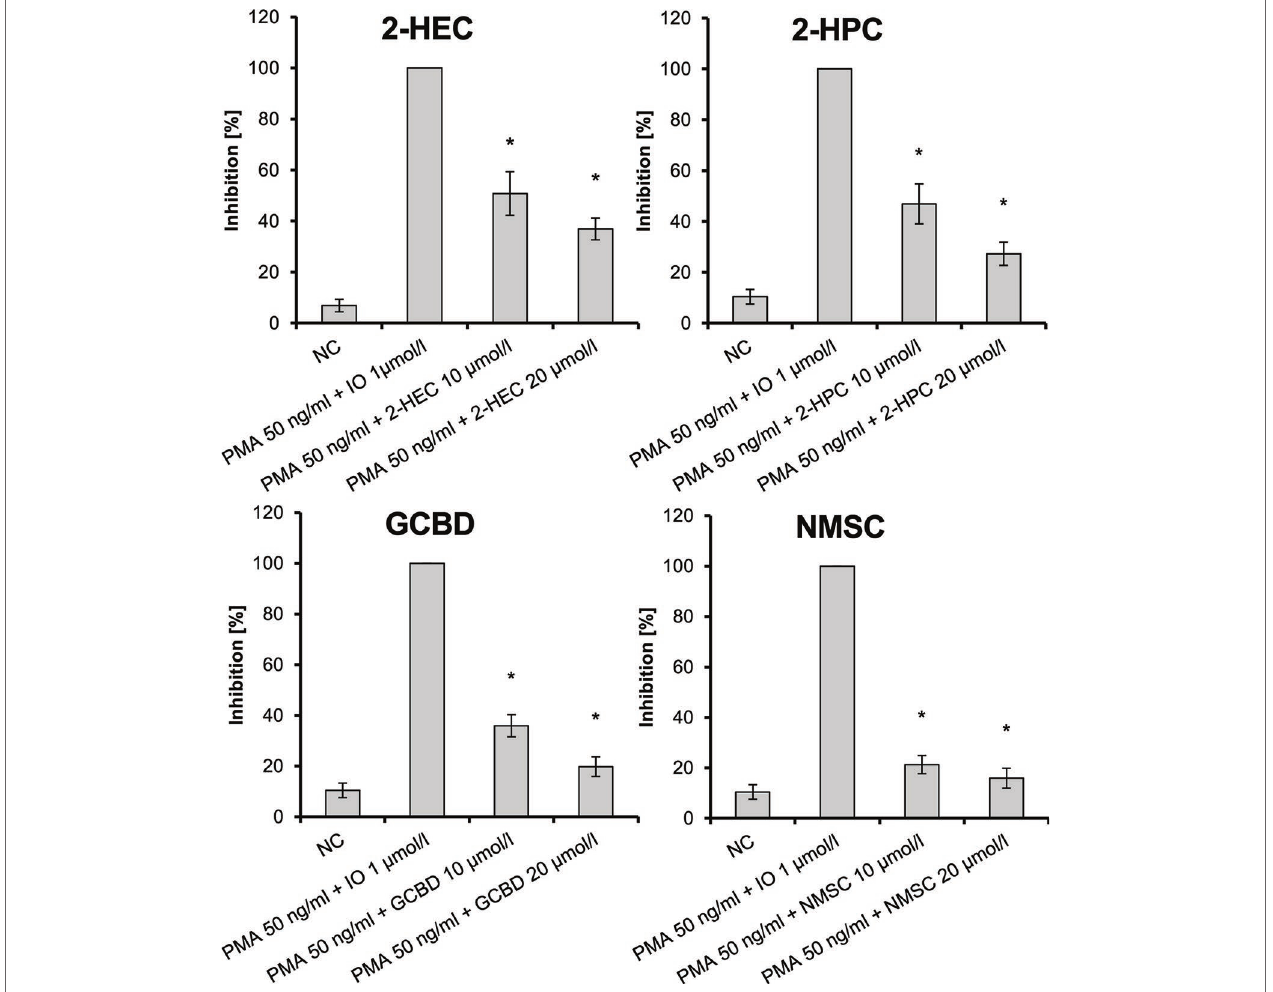
FigURE 6 | Inhibition of PMA/IO‑induced NFAT activation in Jurkat T‑cells given as the percent reduced expression of NFAT‑luc; IO, ionomycin; NC, negative control; NFAT, nuclear factor of activated T‑cells; PMA, phorbol‑12‑myristate‑13‑acetate; n = 3 independent experiments; error bars represent SEM, * p < 0.1.